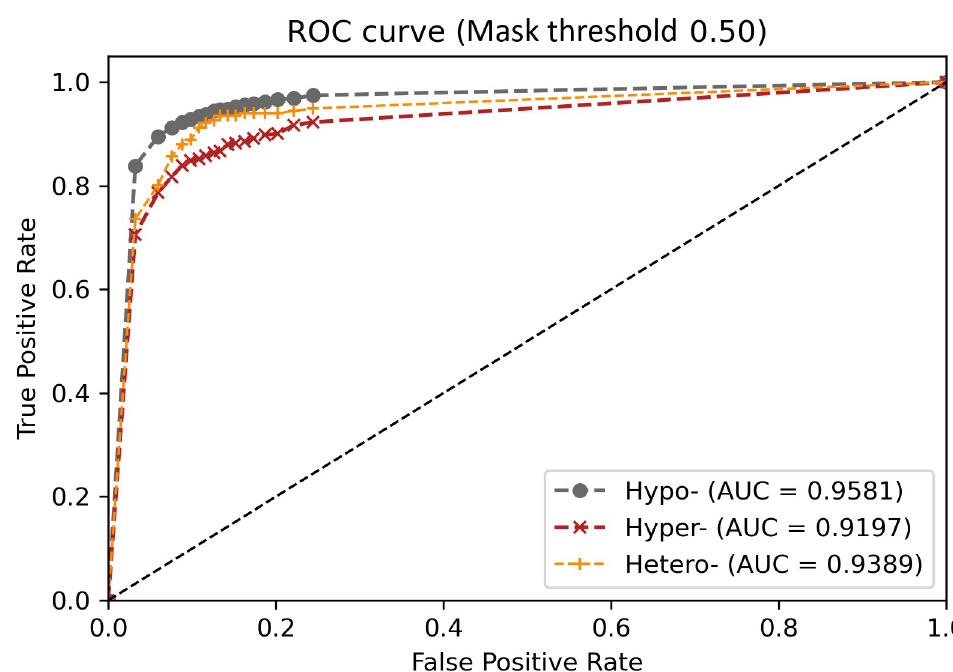
Fig 8. Receiver operating characteristic curve of lesion detection inference for different densities.